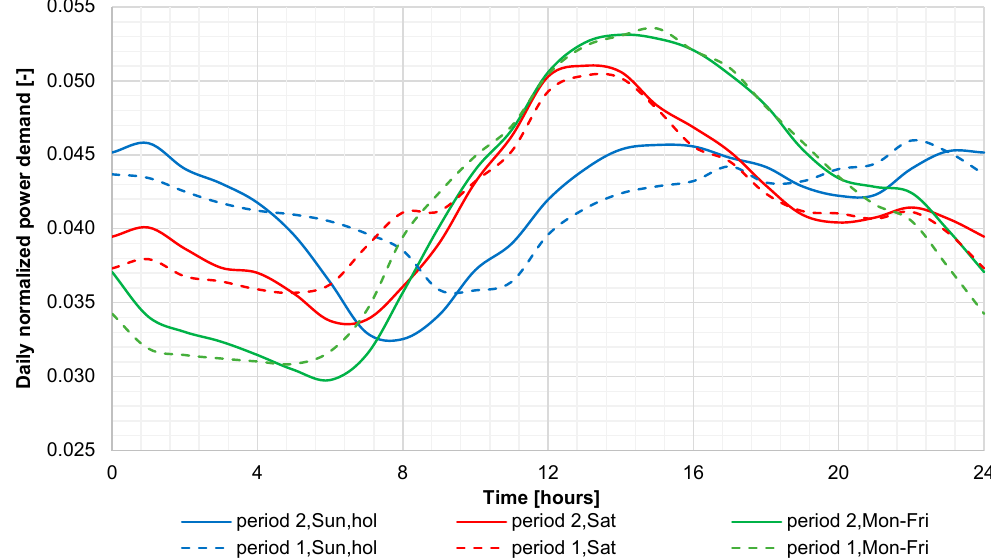
Figure 4. Normalized daily electrical energy demand of the user for di ff erent year periods and types of day.